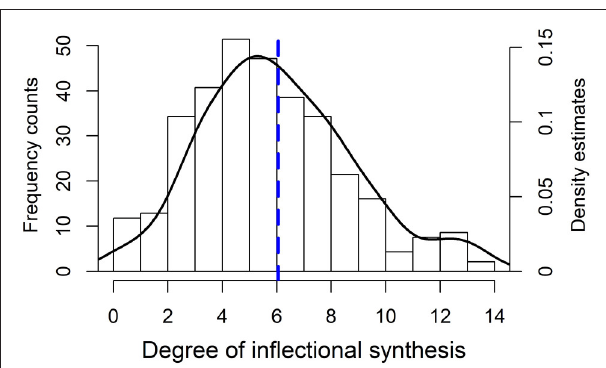
FIGURE 2 | Frequency histogram and the superimposed density estimates for the degree of inflectional synthesis of the verb in the sample languages. The dotted vertical line represents the